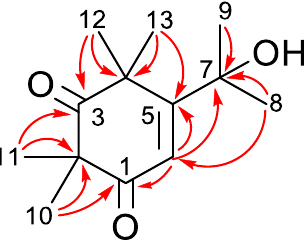
Figure 2. Key HMBC (red arrows) correlations observed in subulatone A ( 1 ). Table 1. 1 H and 13 C NMR spectroscopic data for subulatone A ( 1 ) in CDCl 3 ( δ in ppm, J in Hz). no.